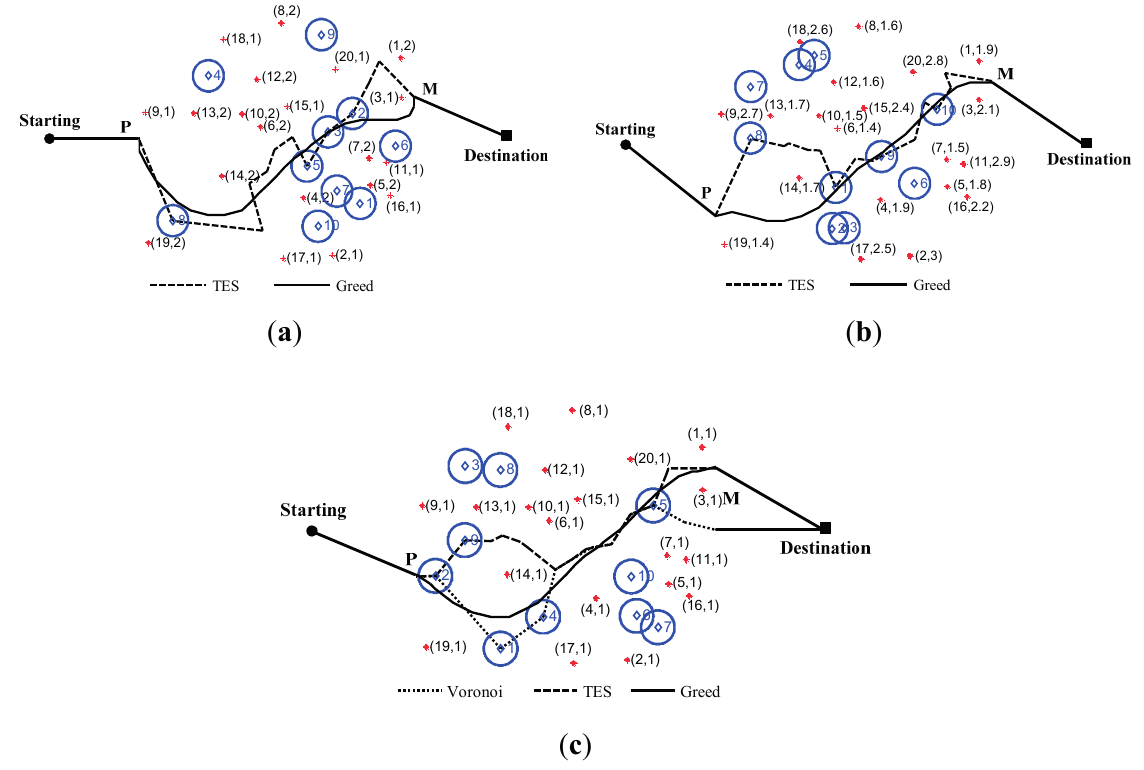
Figure 6. Comparison of trajectories between TES, greedy algorithm, and Voronoi algorithm. ( a ) Two-stage heterogeneous network; ( b ) Multi-stage heterogeneous network; ( c ) Homogeneous network. Where, tag ( i , sensing